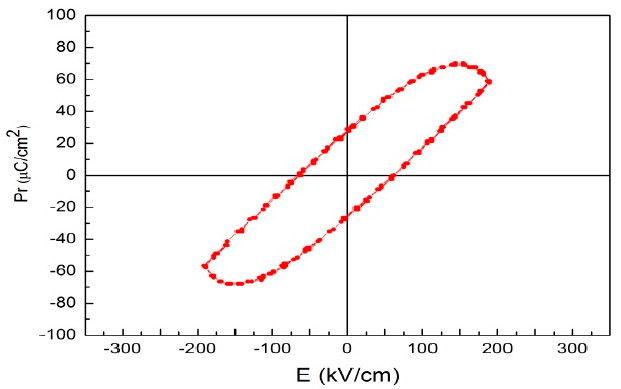
Figure 4. Ferroelectric hysteresis loops of a BPFMO/BGTWO bilayer thin film.